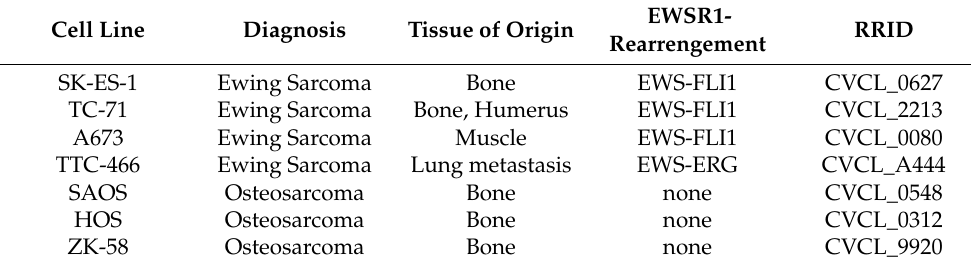
Table 1. Characteristics of cell lines used for the